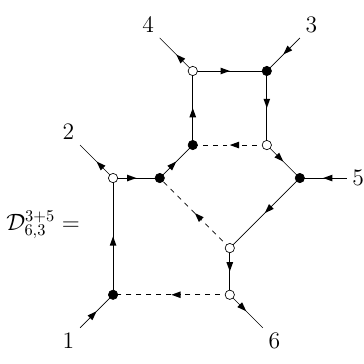
Figure 10 . On-shell diagram combining a 3-point MHV amplitude with a 5-point MHV amplitude. This diagram needs to be summed over the permutations 2 ↔ 4 and 3 ↔ 5